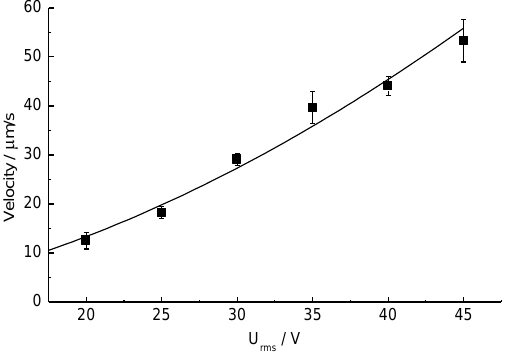
Figure 4. Pumping velocities induced in the flow-return path of the sensorized cell-culture system. Each data point represents the means of 10 tracer particles near the center of the